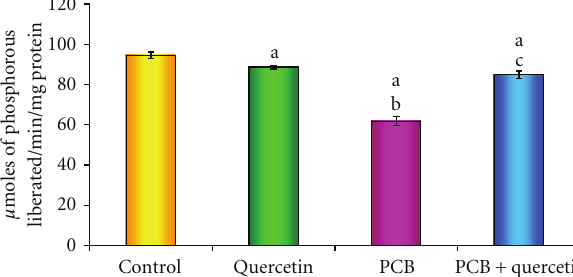
Figure 5: E ff ect of quercetin on creatine kinase in hippocampus of PCBs-exposed adult rats. Each bar represents mean ± SEM of 6 animals. Statistical significance is at P < 0 . 05 (a: Control versus others; b: Quercetin versus PCB, PCB + Quer; c: PCB versus PCB + Quer).